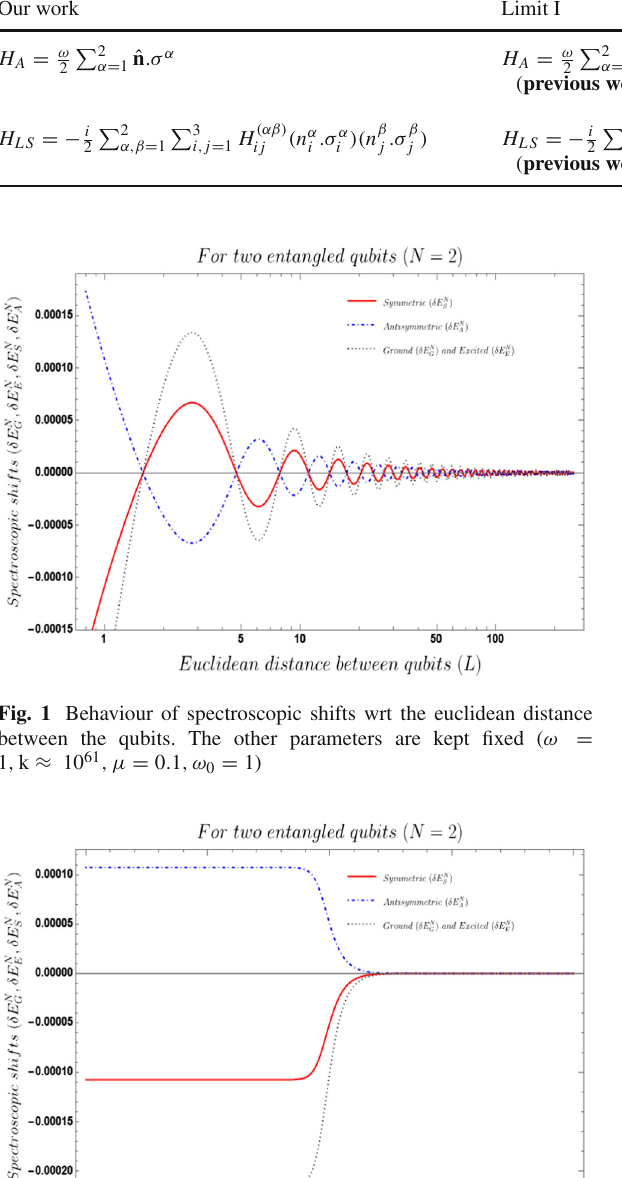
values of L , the shifts fluctuate with a very large amplitude. The rate of fluctuation increases with increasing L with a decreasing amplitude and for asymptotically large value of L the shifts diminish to zero. A naive interpretation from this plot can be that to measure a finite shift, smaller values of L is preferred to larger values.